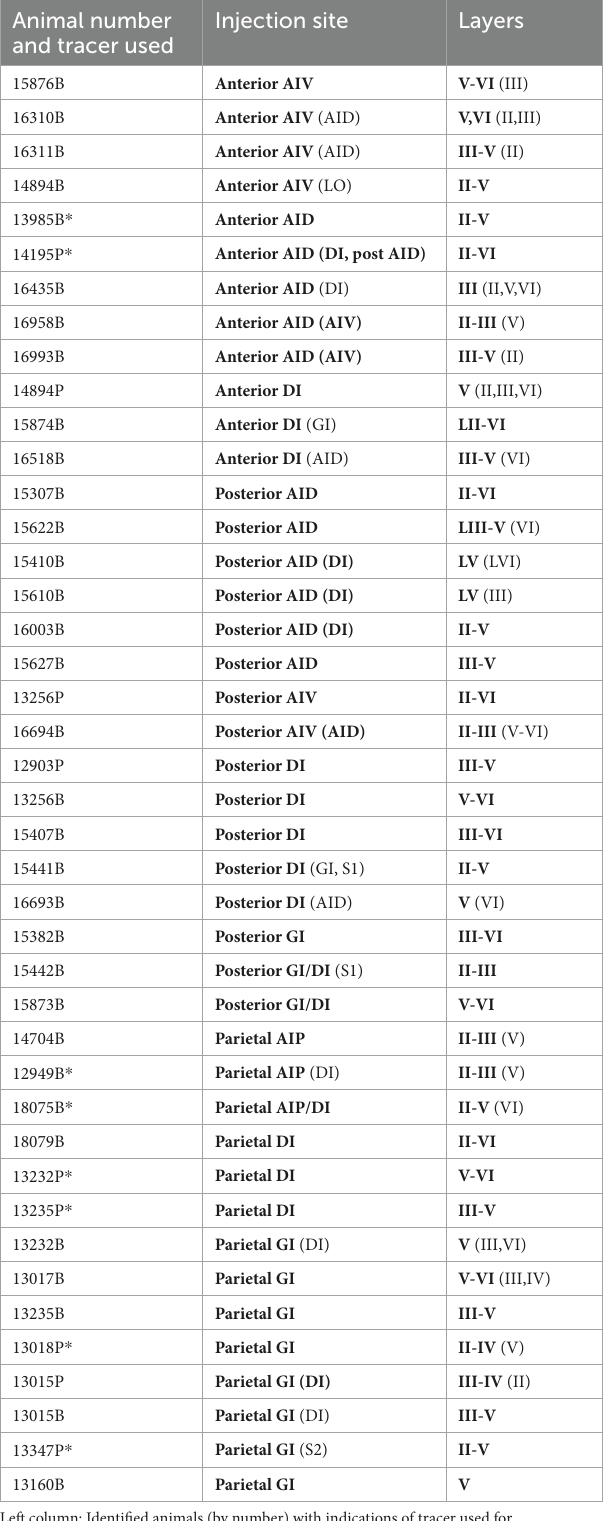
Left column: Identified animals (by number) with indications of tracer used for iontophoretic injection: Phaseolus vulgaris leucoagglutinin and Biotinylated dextran amine 10KD. Asterix behind the animal number indicates that the tracing data for the complete brain are available at EBRAINS (Mathiasen et al., 2020). Middle and right column: main insular division(s) and laminae injected. For each case regional and laminar position of the tracer deposit are specified. Regions and layers labeled in bold indicate the main injection sites, with bold text in brackets indicating a less extensive involvement of the specified region in the injection site. Regions and layers designated in brackets with normal font indicate a region or layer with only very minor involvement in the